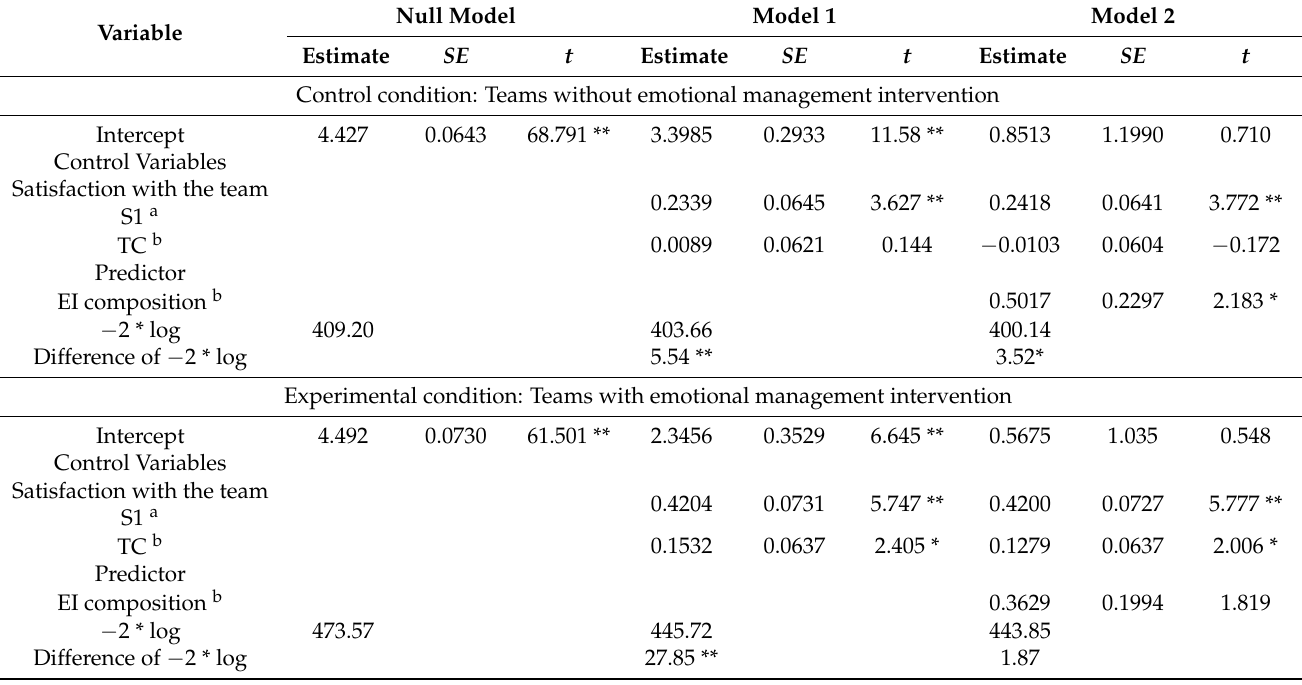
Table 3. Multilevel estimates for models predicting satisfaction with the team in Session